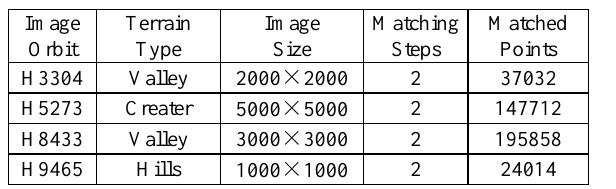
Table 2. Experiment results of DEM extraction